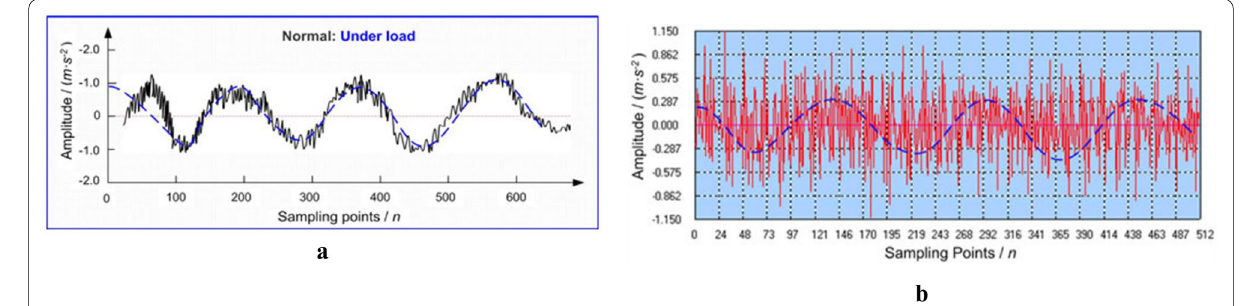
Figure 15 Vibration wave of spindle motor of high speed circular saw: a ECDBS standard wave, b real-time wave from industrial